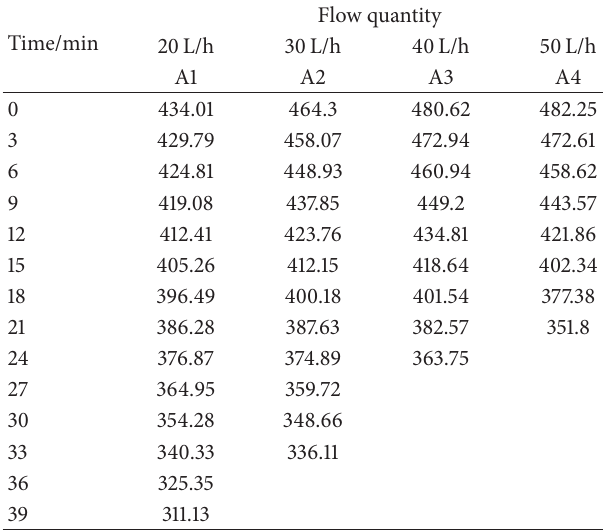
Table 3: Results of dynamic dissolving test for rock salt